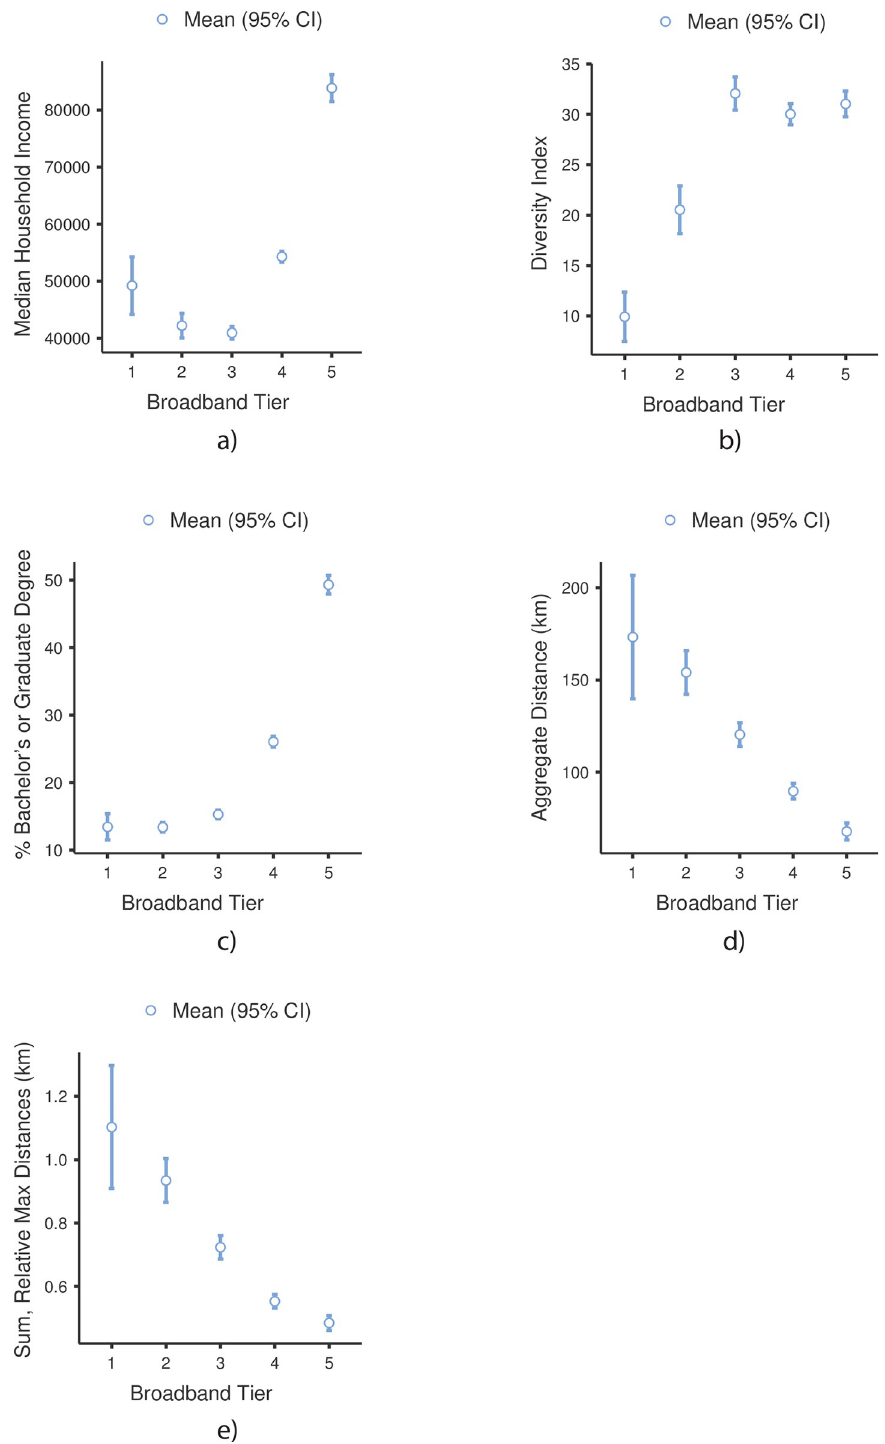
Fig 4. Welch’s ANOVA test